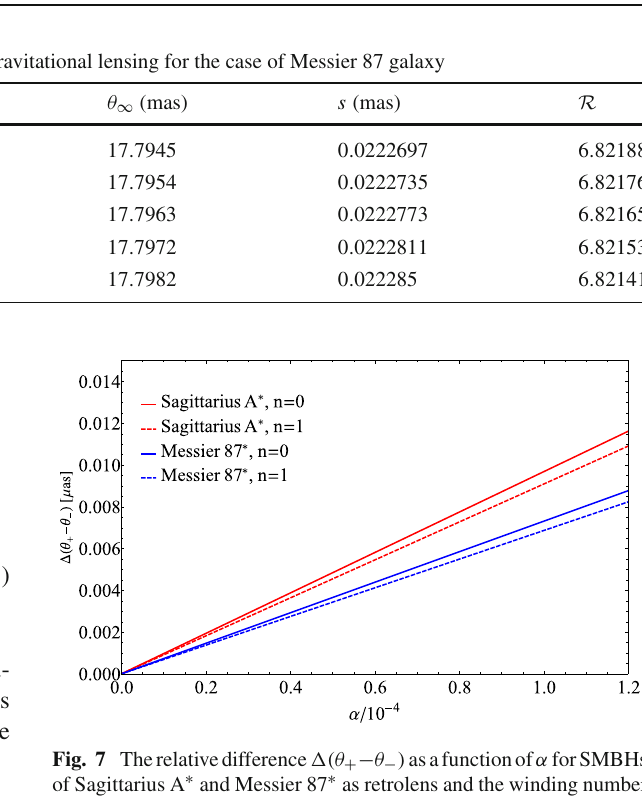
¯ b are dependent only on the parameter α at the that ¯ a and first order of their expansion in α . We observe here that the relative difference (cid:25) m ( 0 ) decreases monotonically as the parameter α increases. This suggests that compared to the Schwarzschild retrolens the maximal brightness of the image is highly amplified for the region of negative α